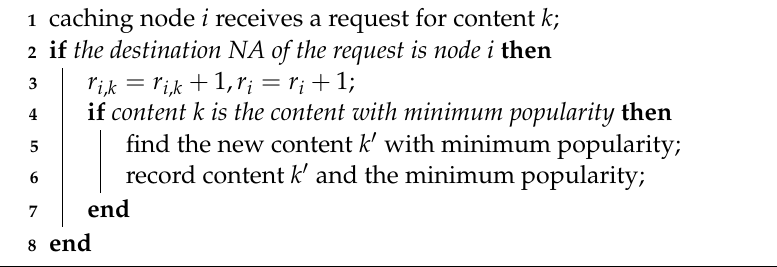
Algorithm 1: Popularity